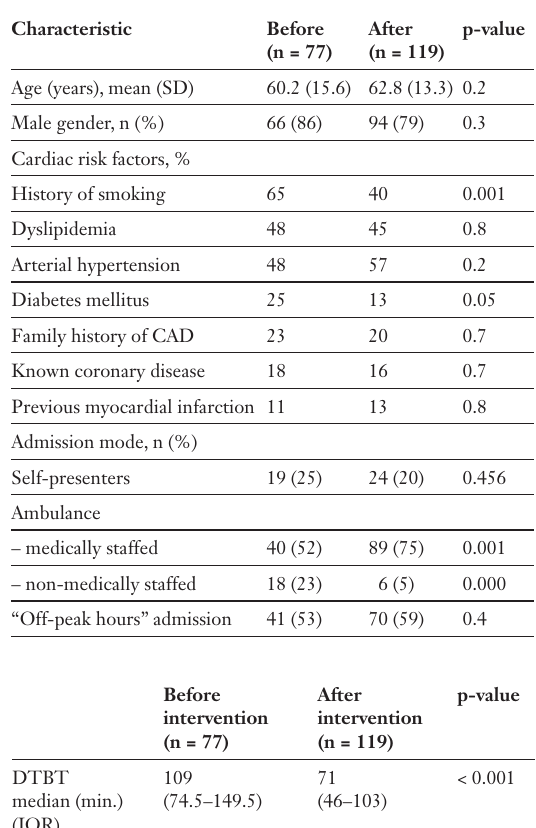
Median DTBT and proportion of STEMI patients with DTBT <90 minutes before and after interven-